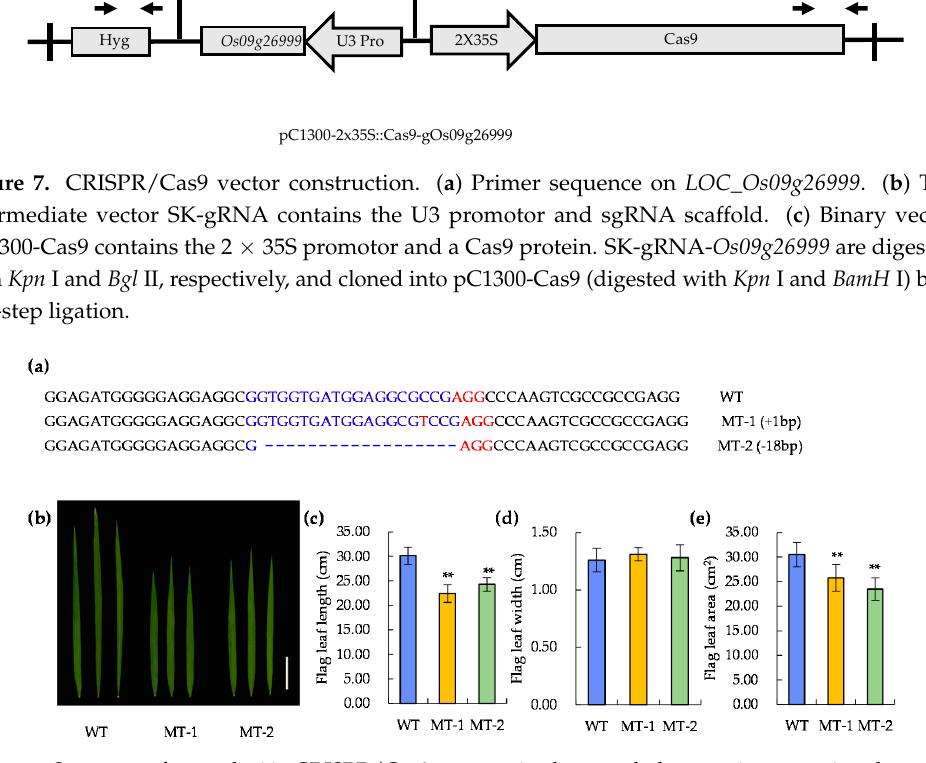
Figure 8. Sequence of target loci in CRISPR/Cas9 transgenic plants and phenotypic comparison between the knockout and wild-type (WT) plants. ( a ) Sequence variation of target loci in two transgenic plants. ( b ) Flag leaf variation; bar = 5 cm. Difference in ( c ) flag leaf length (cm), ( d ) flag leaf width (cm), and ( e ) flag leaf area. WT, Nipponbare; MT-1, Mutant 1; MT-2, Mutant 2. Data are represented as mean ± SD ( n = 15). Asterisks represent significant difference determined by Student’s t -test at p -value <0.01 (**). Table 6. The position of nine SNPs in the promoter of LOC_Os09g26999.